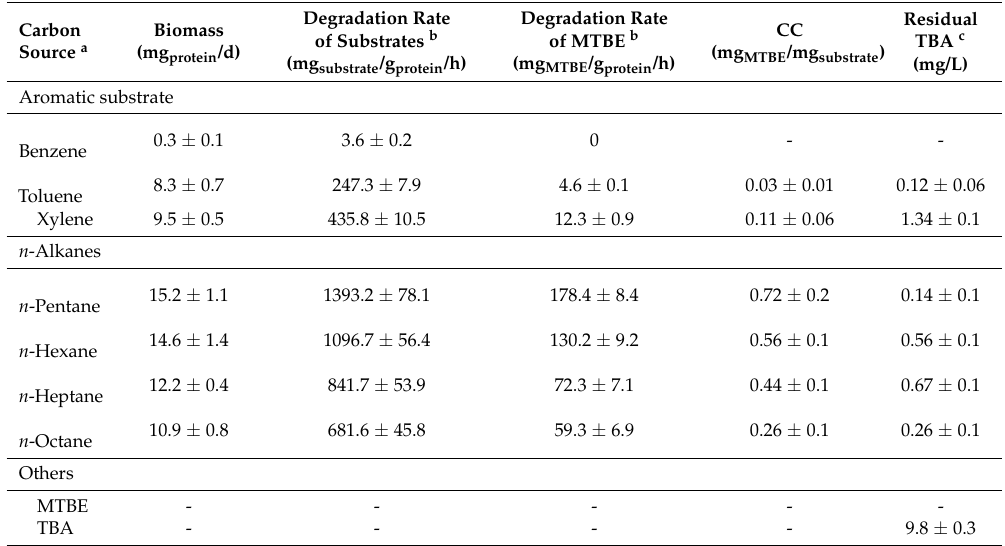
Table 2. Specific degradation rates and products by Pseudomonas sp. DZ13 on diverse